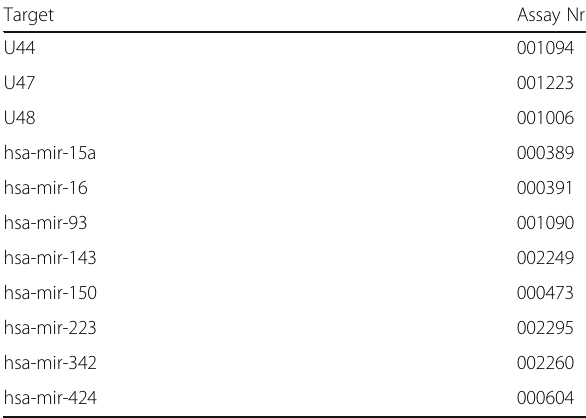
Table 6 TaqMan miRNA assays Target